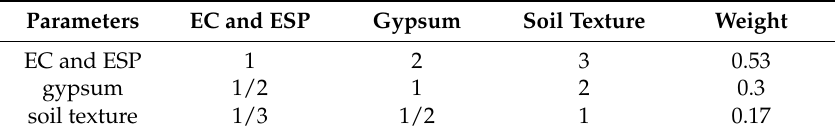
Table 7. Pairwise comparison matrix using the best search and genetic search